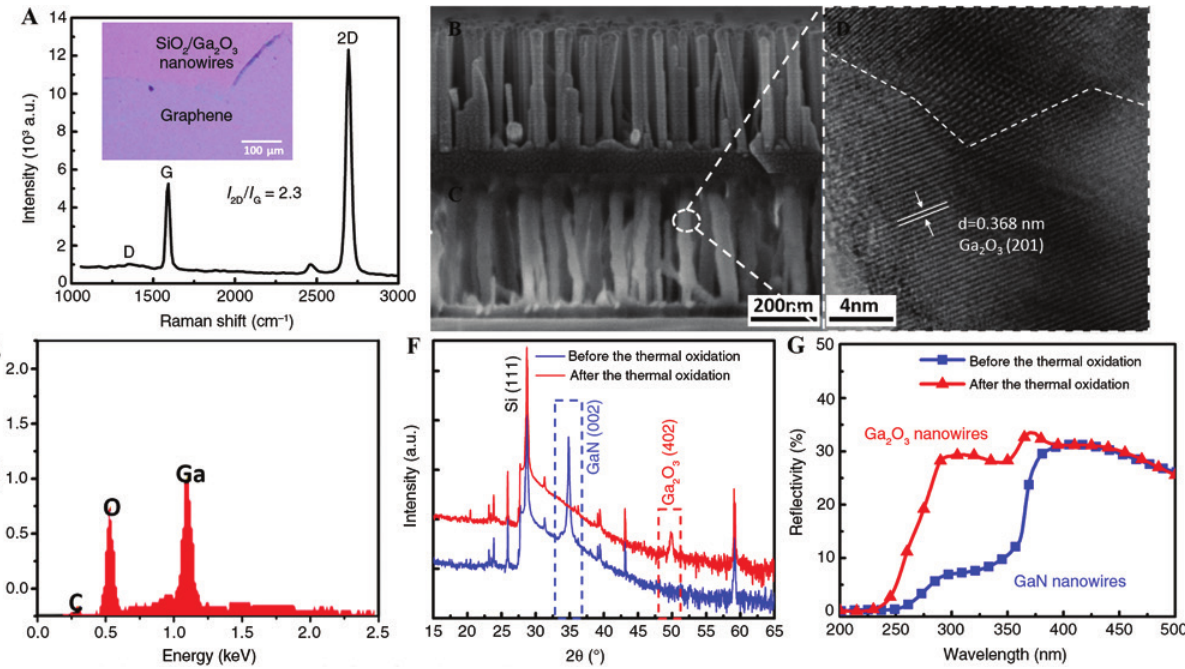
Figure 2: Morphology and optical characterization of graphene and nanowire arrays. (A) Raman spectrum of the monolayer graphene film with the optical microscopy image of graphene and SiO inset. (B and C) FESEM images of vertical GaN and Ga of vertical Ga O nanowire arrays on Si substrate. Si signal from the substrate at 1.7 keV has been removed to make other signals more 2 3 visible. (F and G) XRD patterns and reflection spectra of vertical GaN nanowire arrays before and after thermal